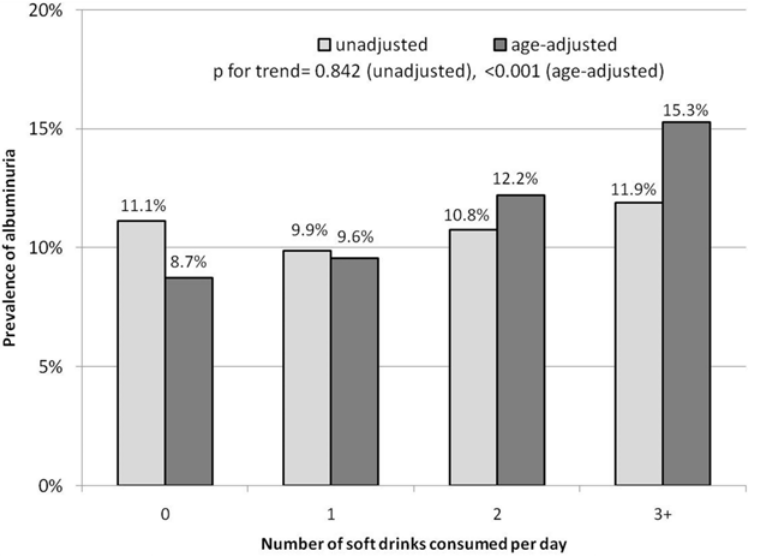
Figure 1. Prevalence of albuminuria among NHANES 1999–2004 non-diabetics age 20 and over, unadjusted and adjusted for age, according to sugary soft drink consumption.